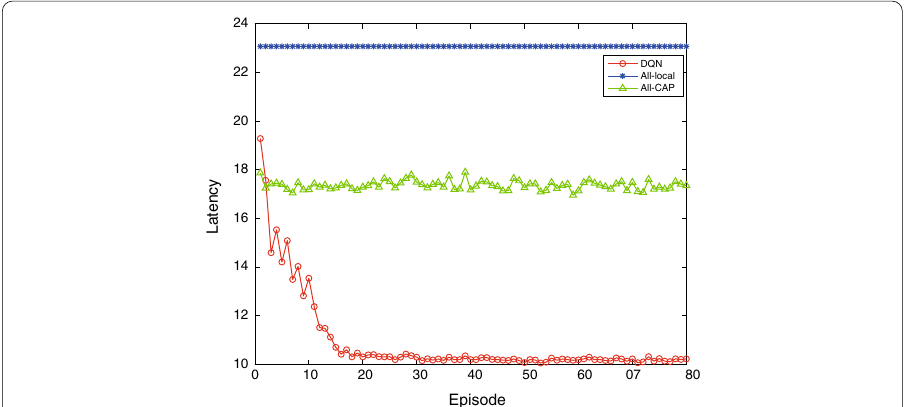
Fig. 3 Performance comparison of three scheme versus the number of